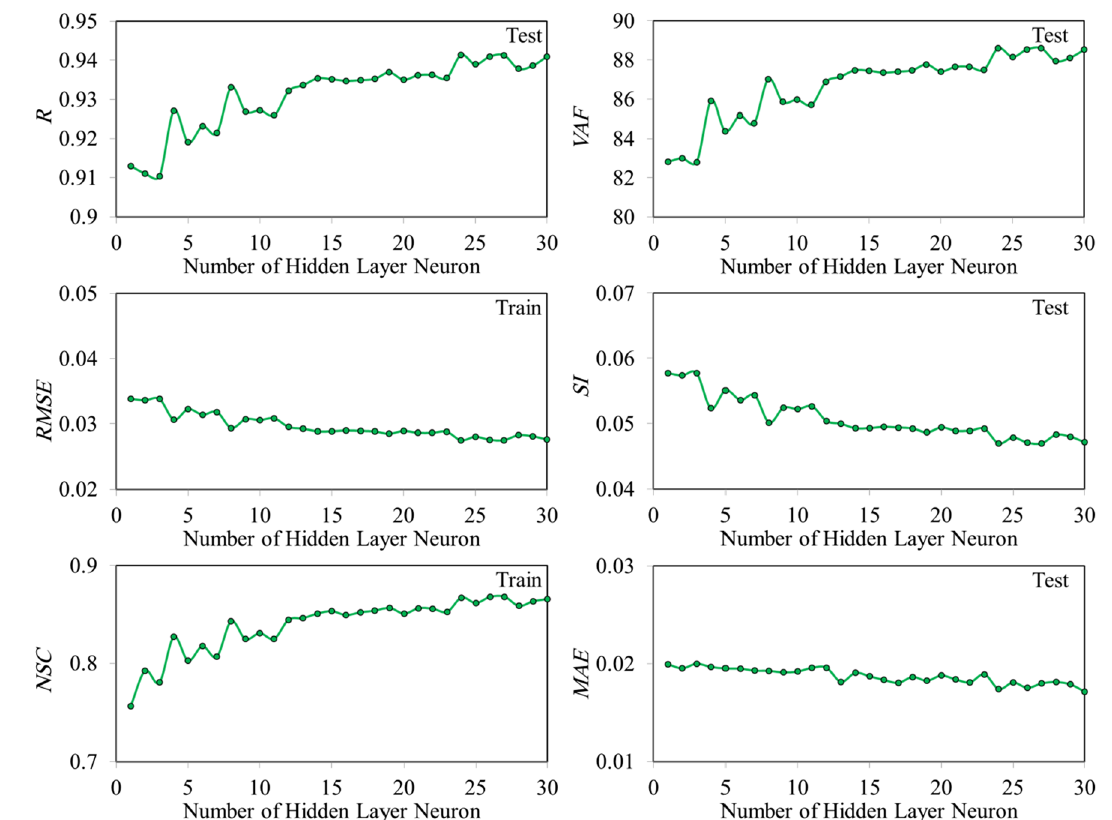
Fig. 4 Changes of NHLN versus different statistical indices in testing mode